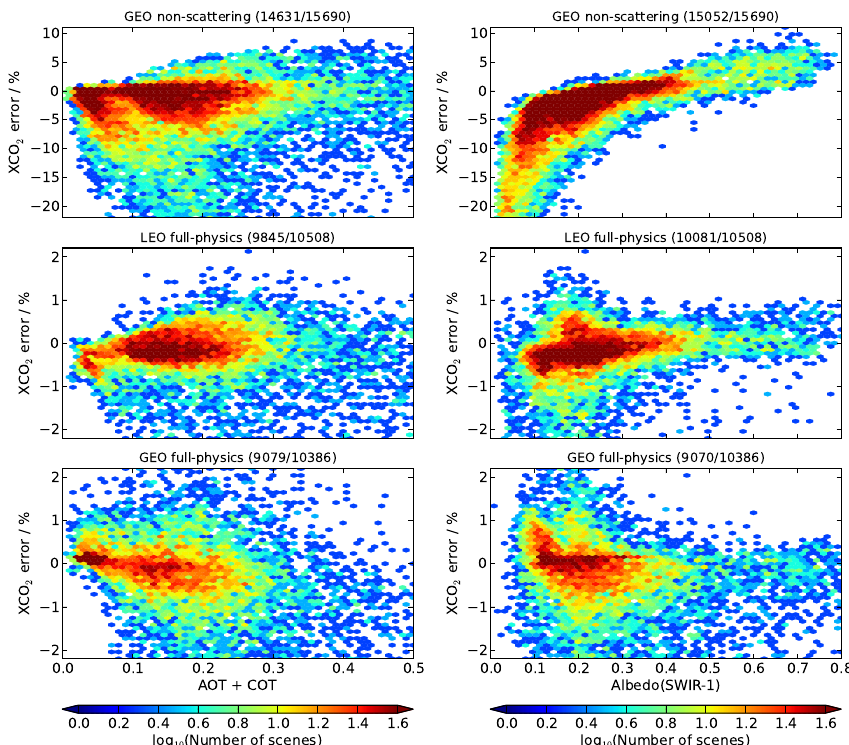
Figure 10. Relative aerosol- and cirrus-induced XCO 2 forward model errors (retrieved / true − 1) for the non-scattering retrievals in GEO geometry (upper panels), for the full-physics retrievals in LEO geometry (middle panels), and for the full-physics retrievals in GEO geometry (lower panels). The left side shows errors as a function of the true aerosol and cirrus optical thickness (AOT + COT at 550nm). The right side shows the errors as a function of albedo in the SWIR-1 band. For the non-scattering retrievals, quality filters screen non-convergent behavior, ocean surfaces, VZA > 70 ◦ , and SZA > 70 ◦ . For the full-physics retrievals, SNR-limited dark scenes in SWIR-3 (albedo × cos(SZA) /π < 0 . 005) are screened in addition. The panel title quotes the respective retrieval configuration and the number of plotted and total scenes in parentheses (plotted/total). The difference (total – plotted) is the number of outlier retrievals beyond the axes scales. The color scale shows logarithmic occurrence. Note that the middle and lower panels have identical occurrence binning, while for the upper panels the ordinate scale and occurrence binning are